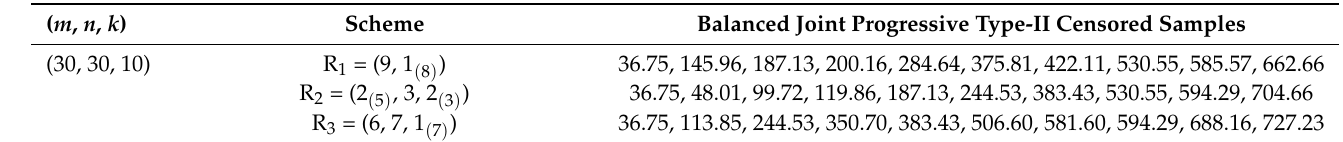
Table 10. Three B-JPC samples from the breaking strength of jute fiber based on different CSs.